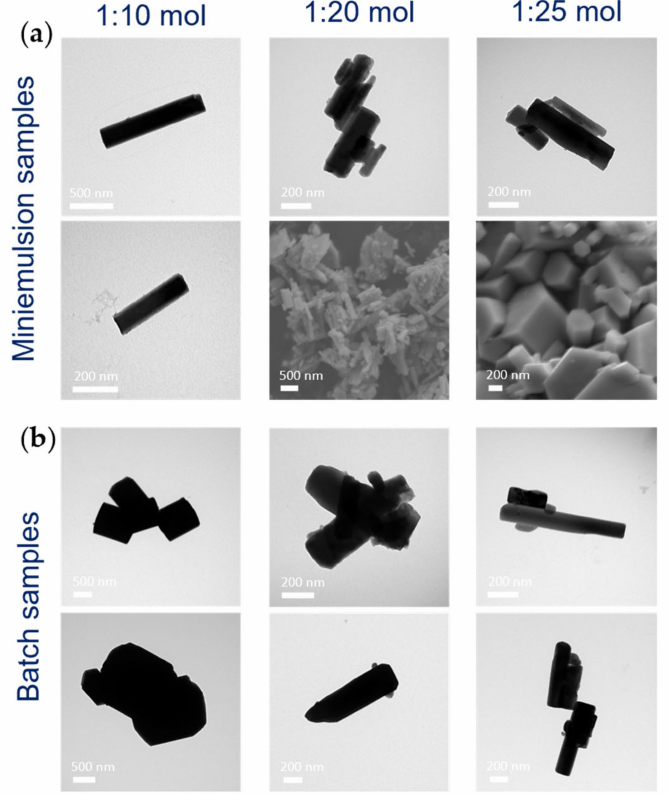
Figure 4. TEM and SEM micrographs of ( a ) ME and ( b ) batch samples synthesized with dif- ferent AHM:HNO 3 molar ratios (1:10, 1:20, and 1:25 mol) and constant AHM concentrations ([AHM] = 0.20 M) and reaction time (24